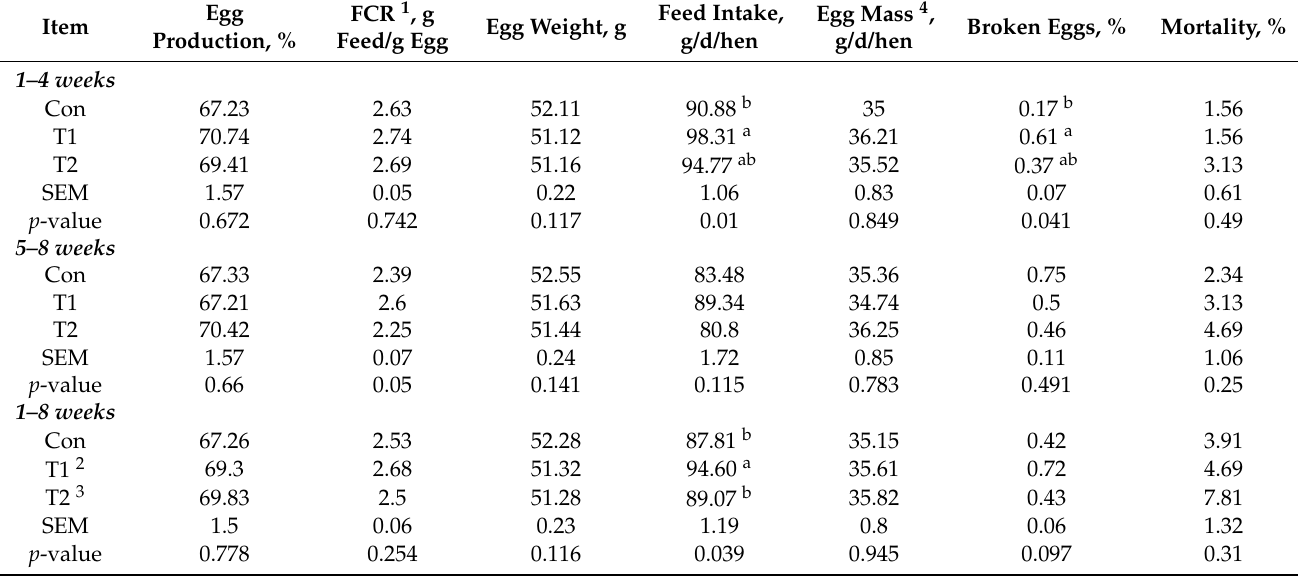
Table A2. The effect of Lactobacillus Salivarius SNK-6 on the productive performance of laying hens.